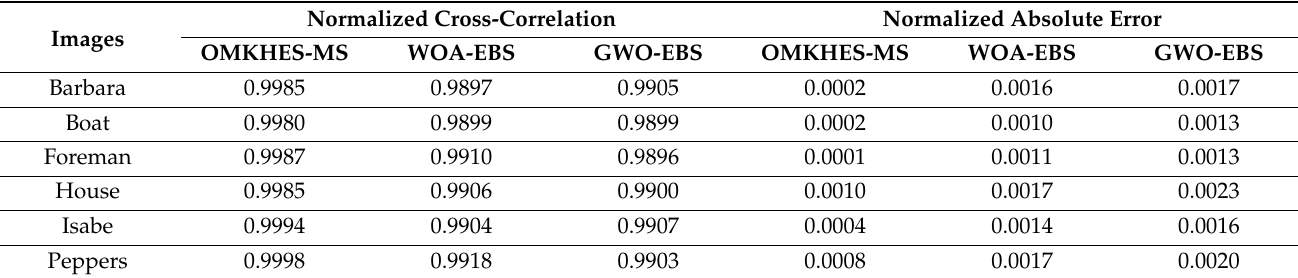
Table 4. NCC and NAE analysis of OMKHES-MS technique with different